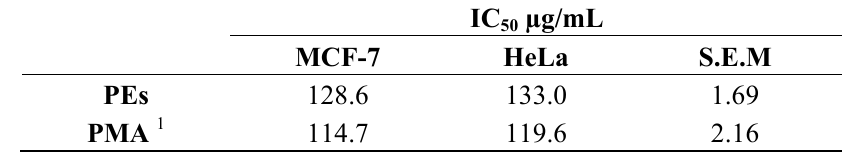
Table 1. IC concentration of isolated PEs and PMA in MCF-7 and HeLa cell lines. 50